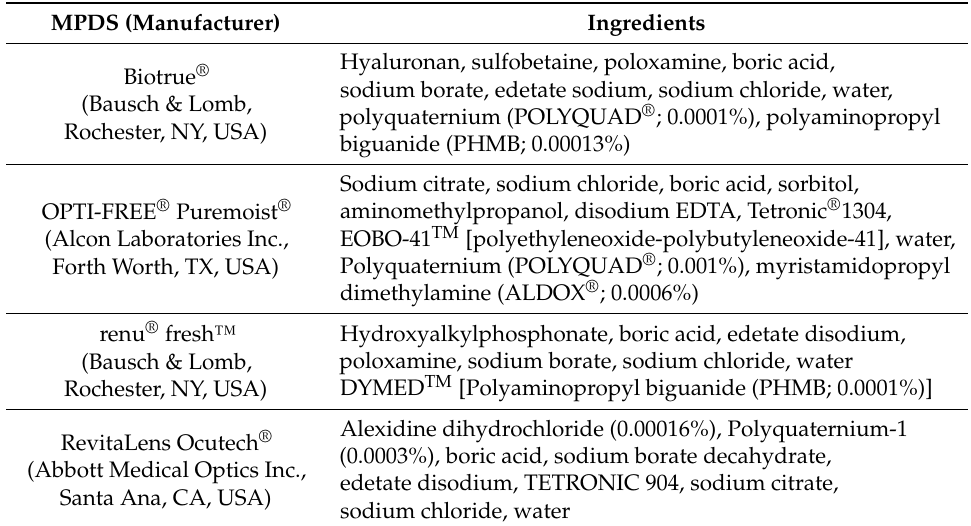
Table 3. Composition of multipurpose disinfectant solutions (MPDS) used in this study.